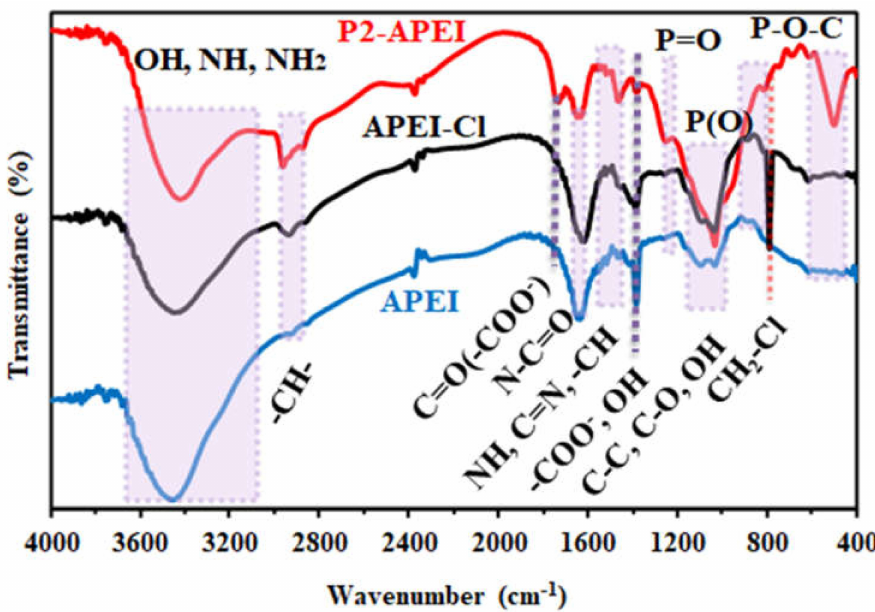
Figure 1. Fourier transform infrared (FTIR) spectra of APEI, APEI-Cl, and P2-APEI